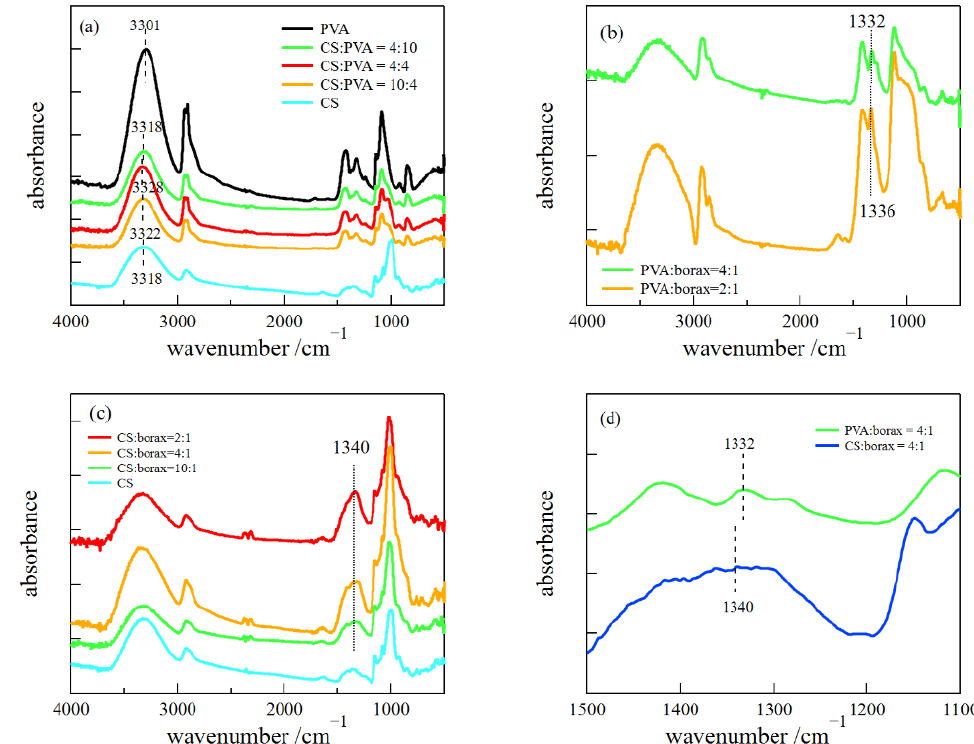
Figure 5. FT-IR spectra of CS/PVA ( a ), PVA/borax ( b ), and CS/borax ( c ), and a comparison between the spectra of PVA/borax and CS/borax ( d ).